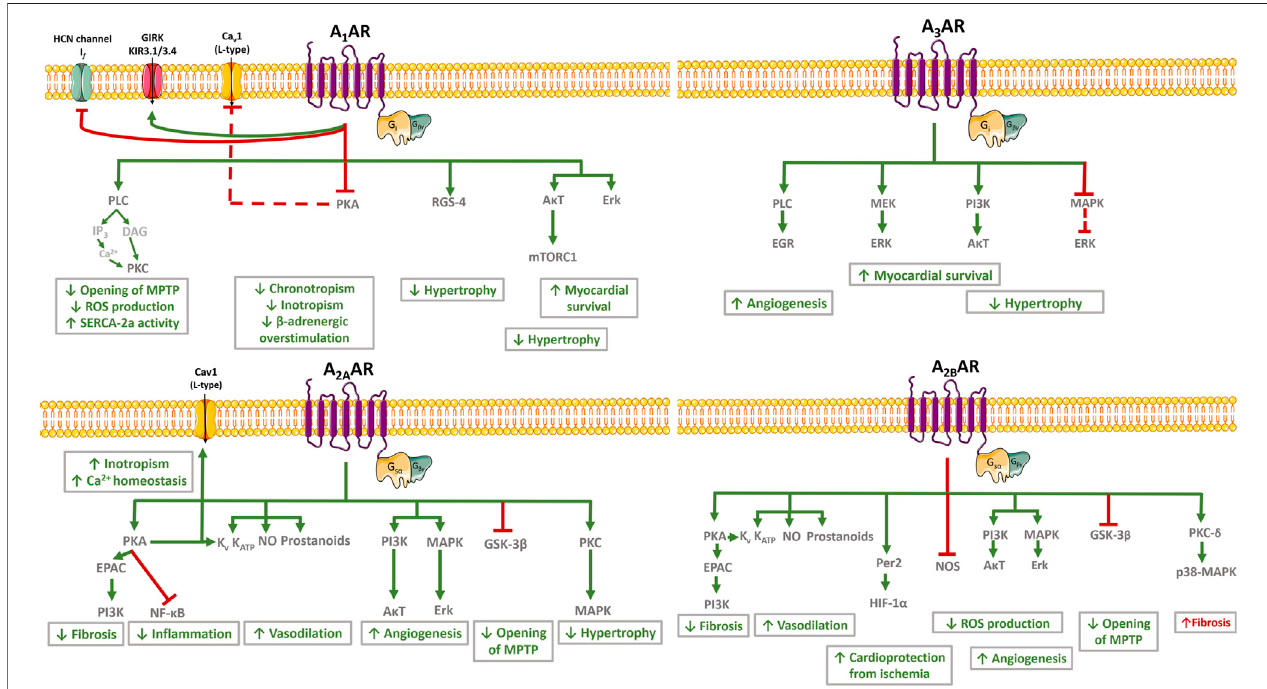
FIGURE2|Schematic representation ofcardiovascular effects ofadenosine andrelatedsignallingpathways. Inthecardiovascularsystem, adenosine exerts protective effects to control neuronal output (anti-adrenergic effect) and in fl ammation, while decreasing cardiac metabolism, myocardial contractility, impulse generation and conduction, and the coronary tone. These effects depend on the cellular type involved. The A 1 AR activation mediates cardioprotective effects by reversing cardiac hypertrophy/remodelling, improving mitochondrial function, enhancing SERCA2a activity and improving Ca 2+ handling. The A 1 AR activation is alsoassociatedwithananti-ischemiceffectbydecreasingcatecholaminereleaseandbycounteracting ß -adrenergicdysfunction.ActivationofA 2A ARattenuatescardiac in fl ammation, fi brosis and hypertrophy, while favoring vasodilation and angiogenesis. Despite the A 2B AR-related vasodilation, angiogenesis and protection from ischemic preconditioning, con fl icting evidence exist regarding the role of this receptor in fi brosis and related cardiac ischemic remodelling. Activation of A 3 AR is also associatedwithcontroversialresults;thisreceptormediatescardioprotectiveeffectsbyincreasingangiogenesisandmyocardialsurvivalduringreperfusion,butitmaybe deleteriousbyaggravatingcardiomyocyteshypertrophy.Greenarrowsandredbarsindicateeffectsinducedorblockedbyadenosinereceptorsactivation,respectively. The red dashed line indicates that the effect is indirectly blocked by adenosine receptors activation. Illustration used elements from Servier Medical Art (http://smart. servier.com)AR,Adenosinereceptor;A κ T,ProteinkinaseB;Ca v 1channel,L-typecalciumchannelsubunit1;DAG,diacylglycerol;EGR,EarlyGrowthResponse;EPAC, Exchange protein directly activated by cAMP; ERK, Extracellular signal-regulated protein kinase; GIRK and KIR3.1/3.4, G protein coupled inwardly rectifying K + channels; GSK-3, Glycogen synthase kinase-3; HCN channels, Hyperpolarization-activated cyclic nucleotide-gated channel; HIF-1 α , Hypoxia-inducible factor-alpha;